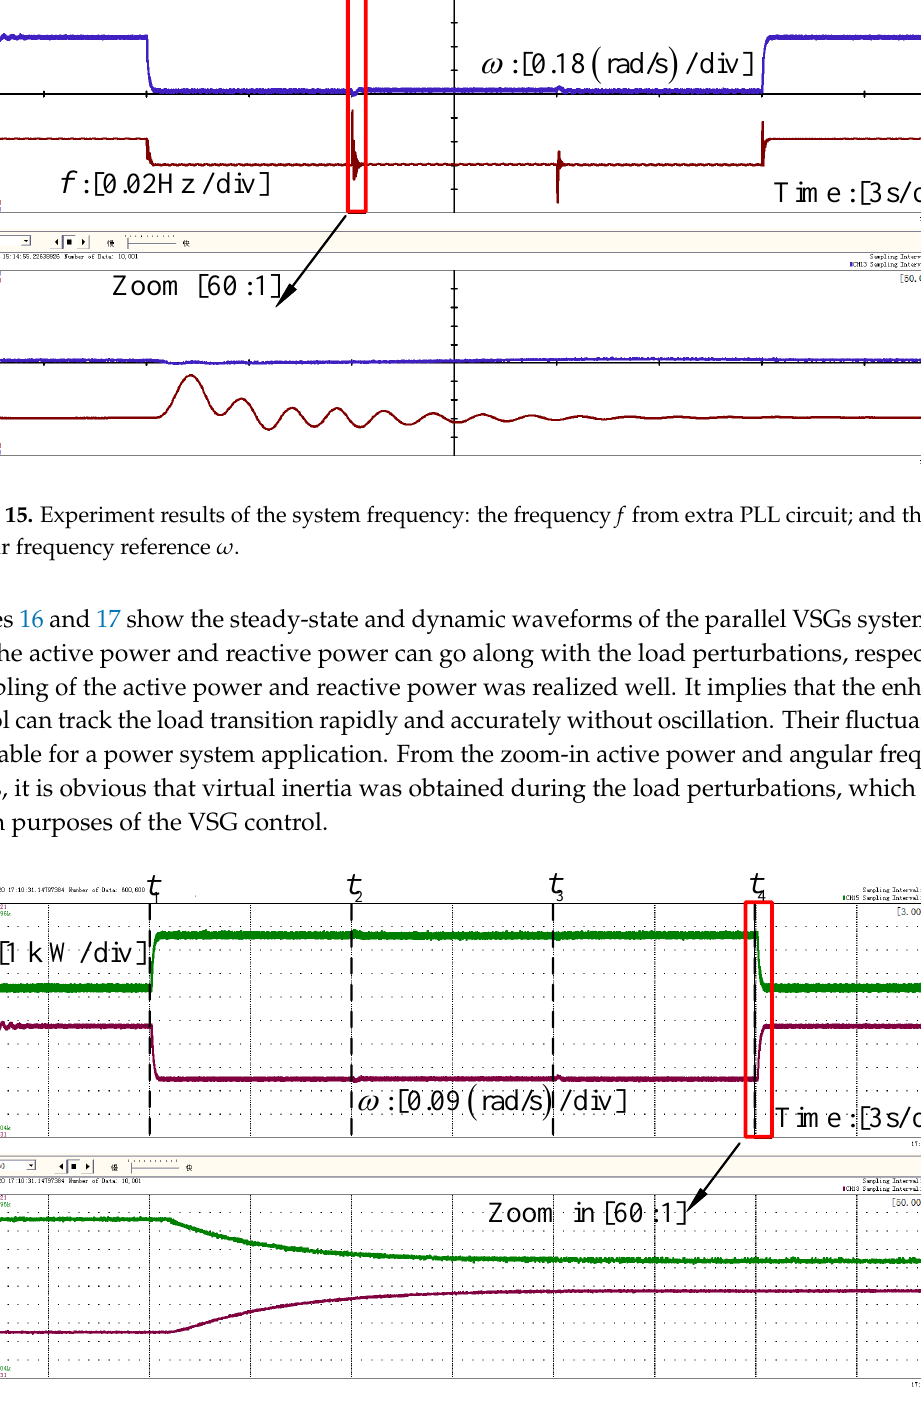
Figure 16. Experiment results: Angular frequency reference and active power at the PCC.